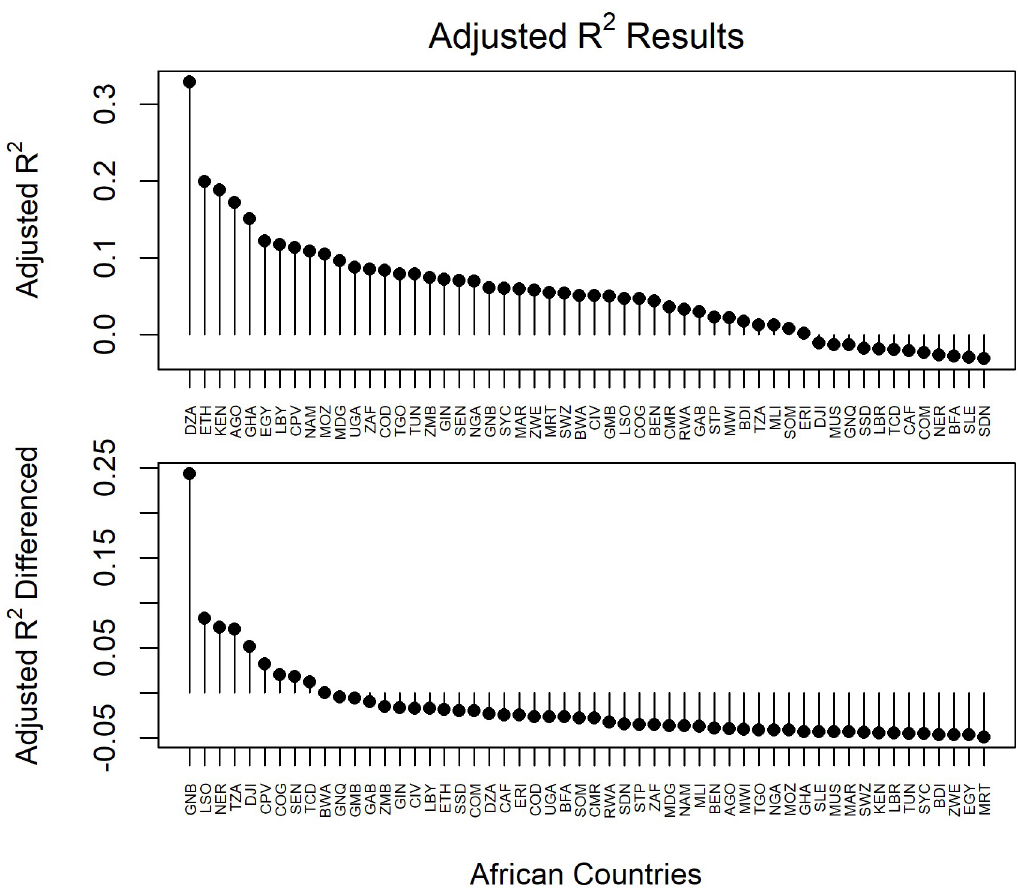
Fig 3. Results of multiple linear regression analysis between COVID-19 incidence and Google Health Trends (GHT) search terms. The adjusted R 2 of the basic (upper panel) and the weighted (bottom panel) regression analysis is depicted here to visually represent the countries from the highest to lowest performance. The countries in this figure are designated by their three-letter Alpha-3 codes as in Fig 1.